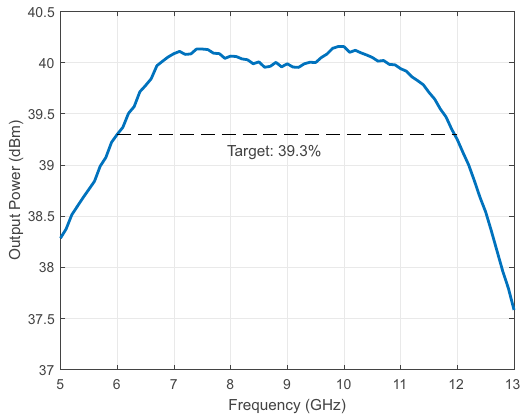
Figure 8. Output power vs. frequency at 5.5 dB compression for the PA using the matching network designed for the 0.5 dB output power